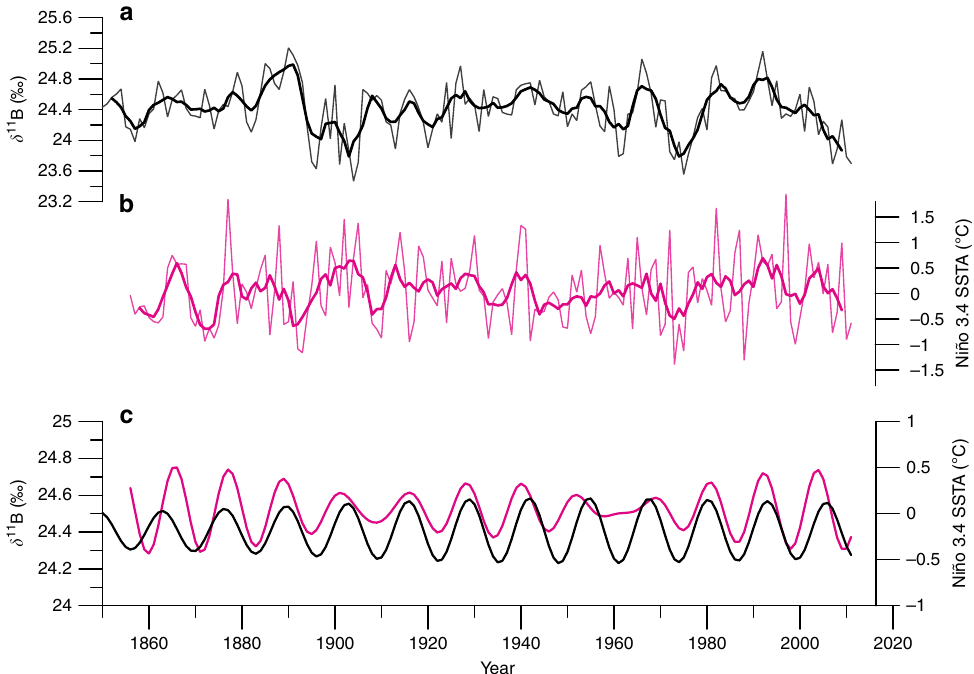
Fig. 6 New Caledonia coral δ 11 B and Niño 3.4 SSTA spectral coherence. a Detrended δ 11 B time series with smoothed 5-year running mean in bold indicating interannual variability. b Detrended Niño Region 3.4 SST anomalies (Niño 3.4 SSTA) 29 with smoothed 5-year running mean in bold indicating interannual variability. c The extracted decadal mode (11 – 12 years) from Singular Spectrum Analysis of the New Caledonia D. heliopora δ 11 B (black) and the Niño 3.4 SSTA (magenta) indicating coherent and synchronous decadal variability across the Paci fi c Ocean, from the southwestern Paci fi c to the far eastern Paci fi